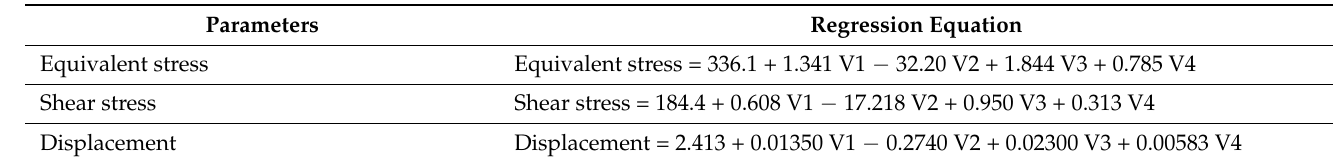
Table 5. The values of R 2 and R 2 adj, respectively, for the regression